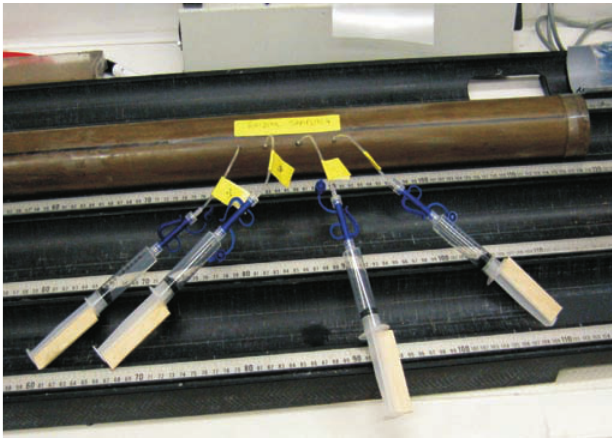
Figure 2. Four Rhizon samplers collecting water under vacuum from a ~10-cm interval of a shallow